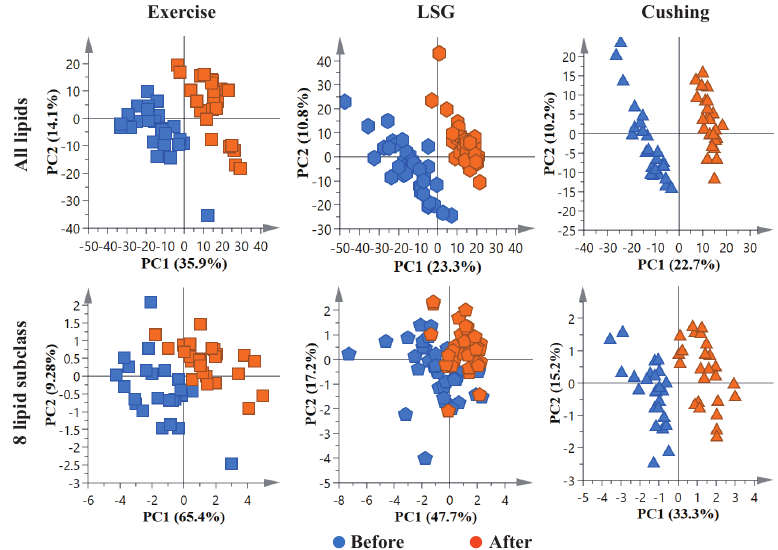
Figure 2. Partial least squares discriminant analysis (PLSDA) analysis. PLSDA analysis of all lipids, and eight lipid subclasses: DG, TG, PC, PE, PI, PS, LPC, and SM.